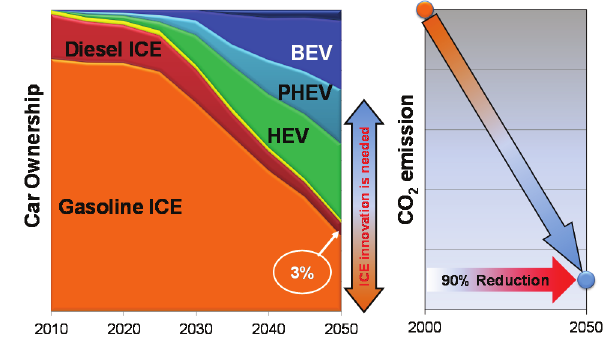
Fig. 1. Future power source trend and CO 2 target [12]